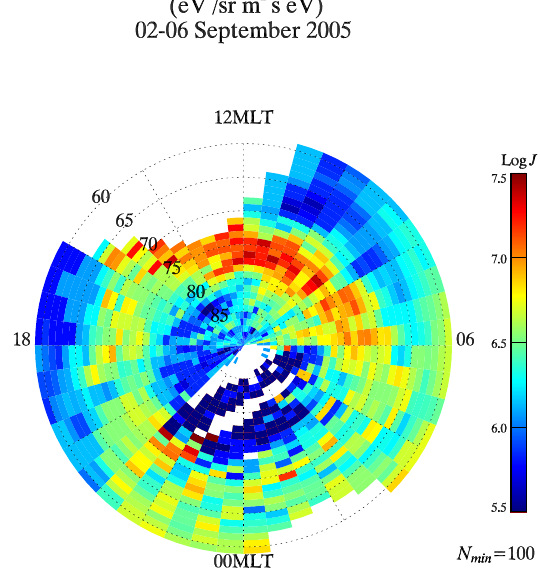
Fig. 14. The same as in Fig. 13 but for DMSP15 differential elec- tron flux at E e = 94.9eV.